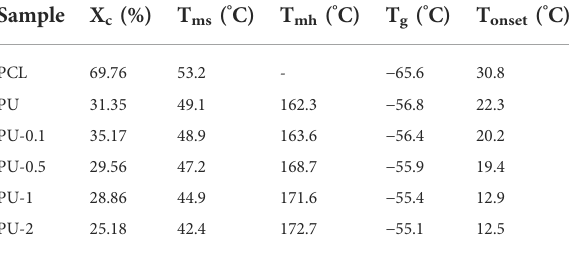
TABLE 2 The degree of crystallinity (X c ,%); and melting (T ms ) and glass transition (T g , ° C) temperatures of the soft segments. The